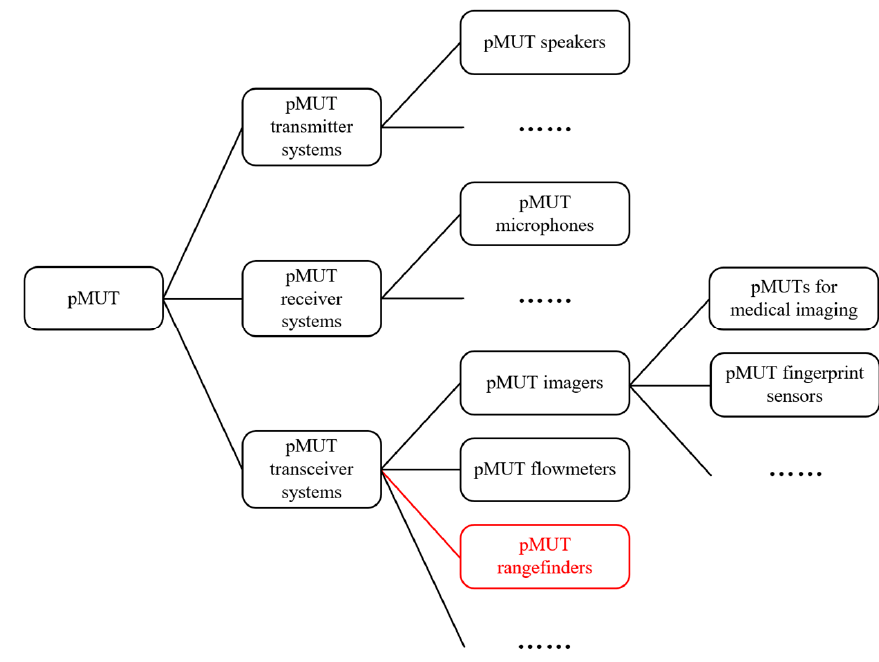
Figure 1. Different applications of pMUTs.